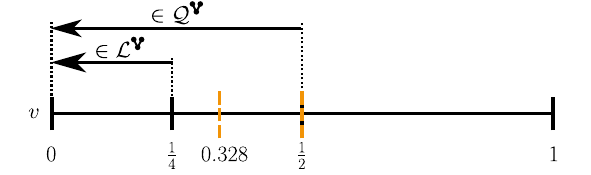
FIG. 12. Summary of results recoverable with quantum in- flation in the tripartite-line scenario in Fig. 3(a) (orange dashed